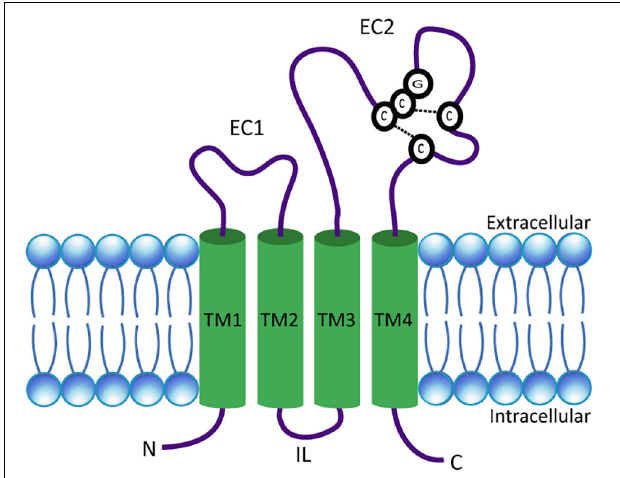
FIGURE 1 | Schematic presentation of a tetraspanin. The model depicts the conserved structural features of tetraspanins. EC1 and EC2 represent the short and large extracellular domains, respectively. Transmembrane domains TM1–TM4 and the CCG motif along with disulfide bonds between two pairs of cysteine residues in EC2 are shown. N- and C-termini as well as the intracellular loop (IL) are located in the